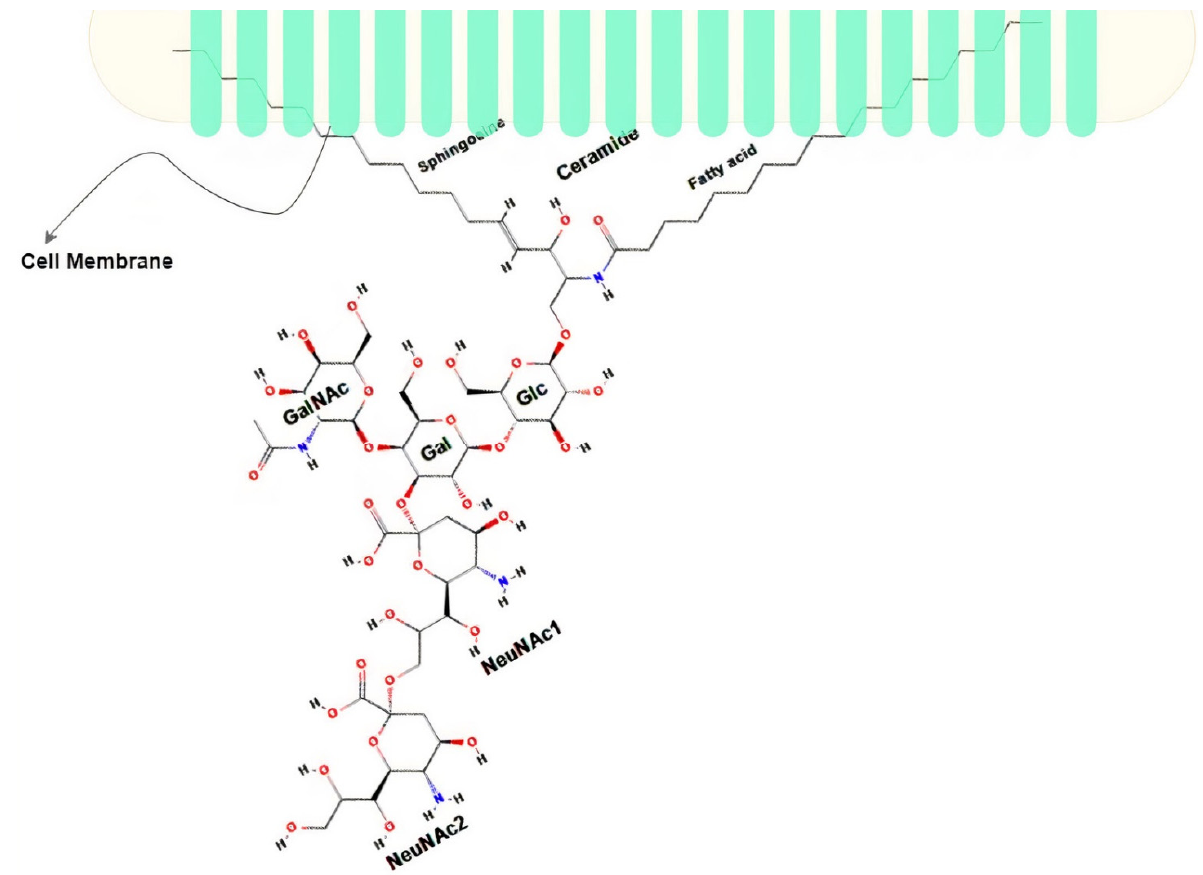
Figure 1. Structure of GD2 adapted from [26]; Sphingosine and Fatty acid are embedded in the cell membrane; Galactose (Gal), Glucose (Glc), N-acetylgalactosamine (GalNAc), and N-acetylneuraminic acid (NeuNAc) are the extracellular part.